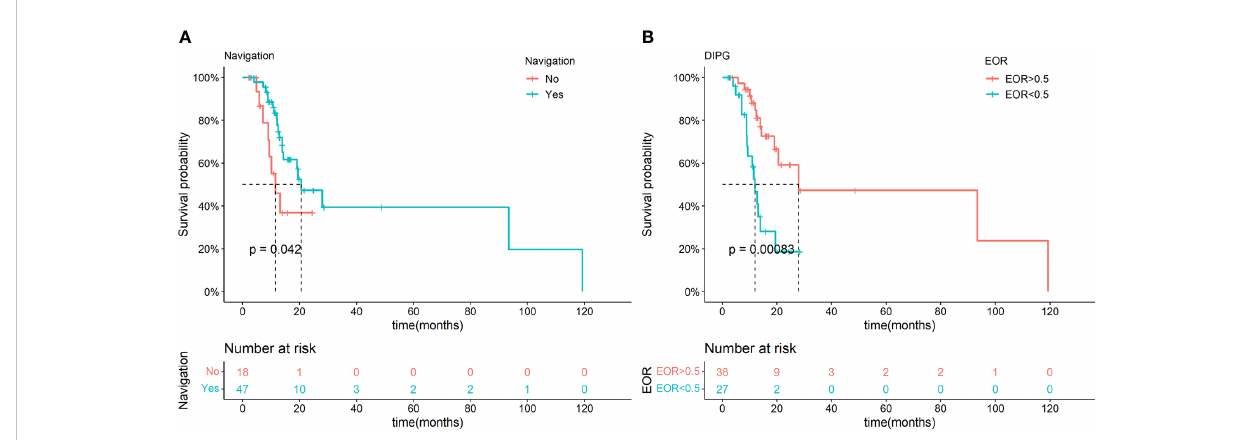
FIGURE 3 Kaplan-Meier analysis of NN and different EOR in the DIPG groups. Signi fi cant difference in OS was observed between NN and non-NN groups in DIPG patients (A) . Signi fi cant difference in OS was observed between different EOR groups in DIPG patients (B)